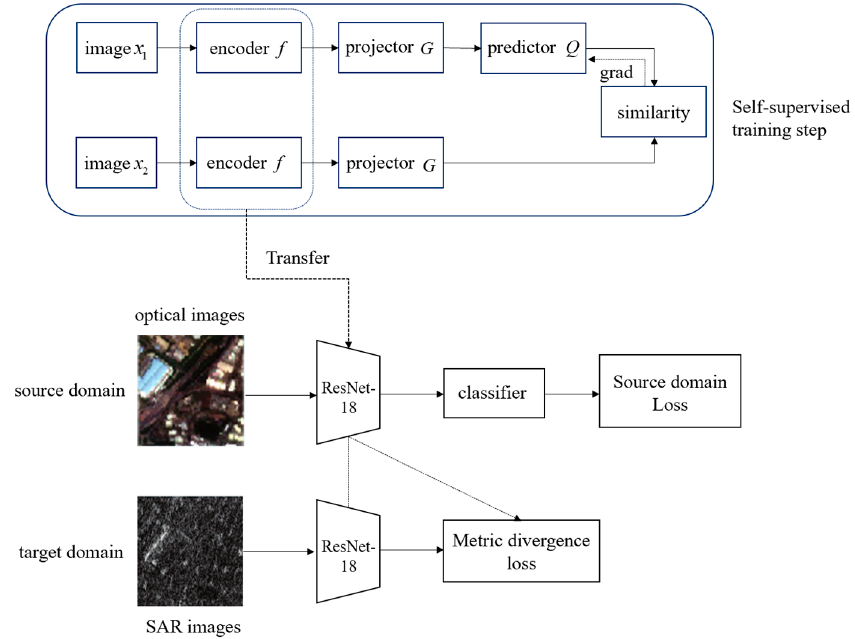
Figure 7. Example of self-supervised pretrained network used in domain adaption task of optical transfer to SAR data.